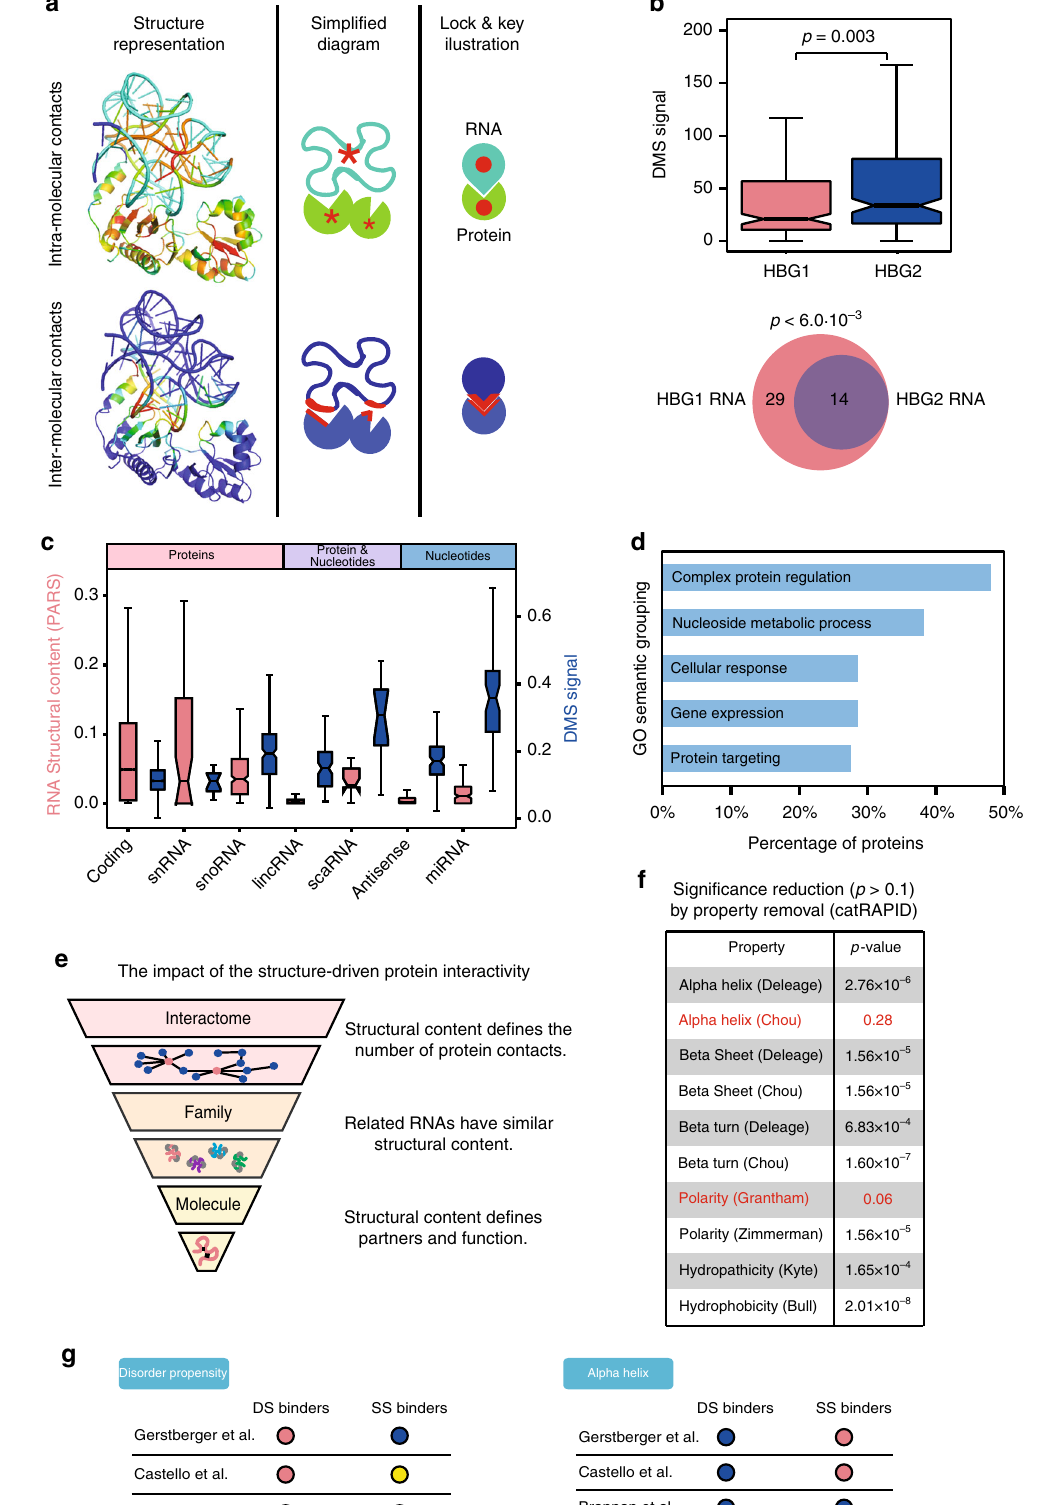
RNA molecules, we analysed which physicochemical properties of the proteins better discriminate the HS and LS sets. We studied all 10 variables used in the catRAPID algorithm (Fig. 2f) 13,32 and removed them one by one to estimate the impact on the pre- diction of RNA – protein interactions. We found that the capacity